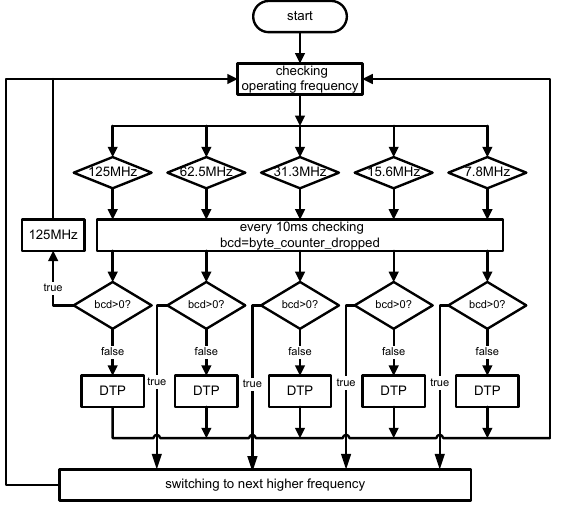
Figure 8. Flowchart of the packet loss-aware